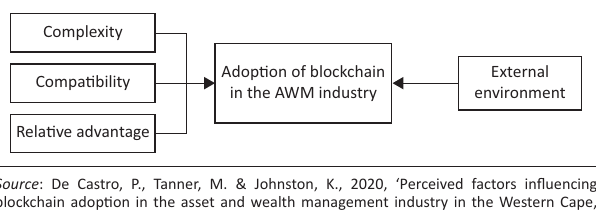
FIGURE 1: Factors affecting the adoption of blockchain in the Asset and Wealth Management industry.